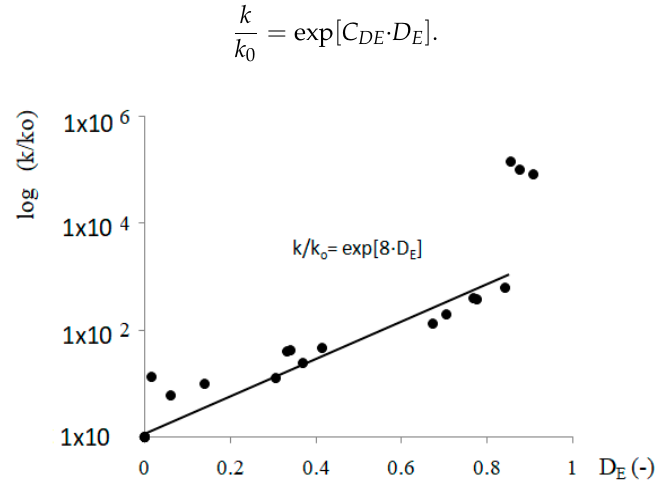
Figure 9. Juxtaposition of permeability (log scale) and damage to unheated concretes (20 °C) and concretes heated to 200, 400, 600, and 800 °C.